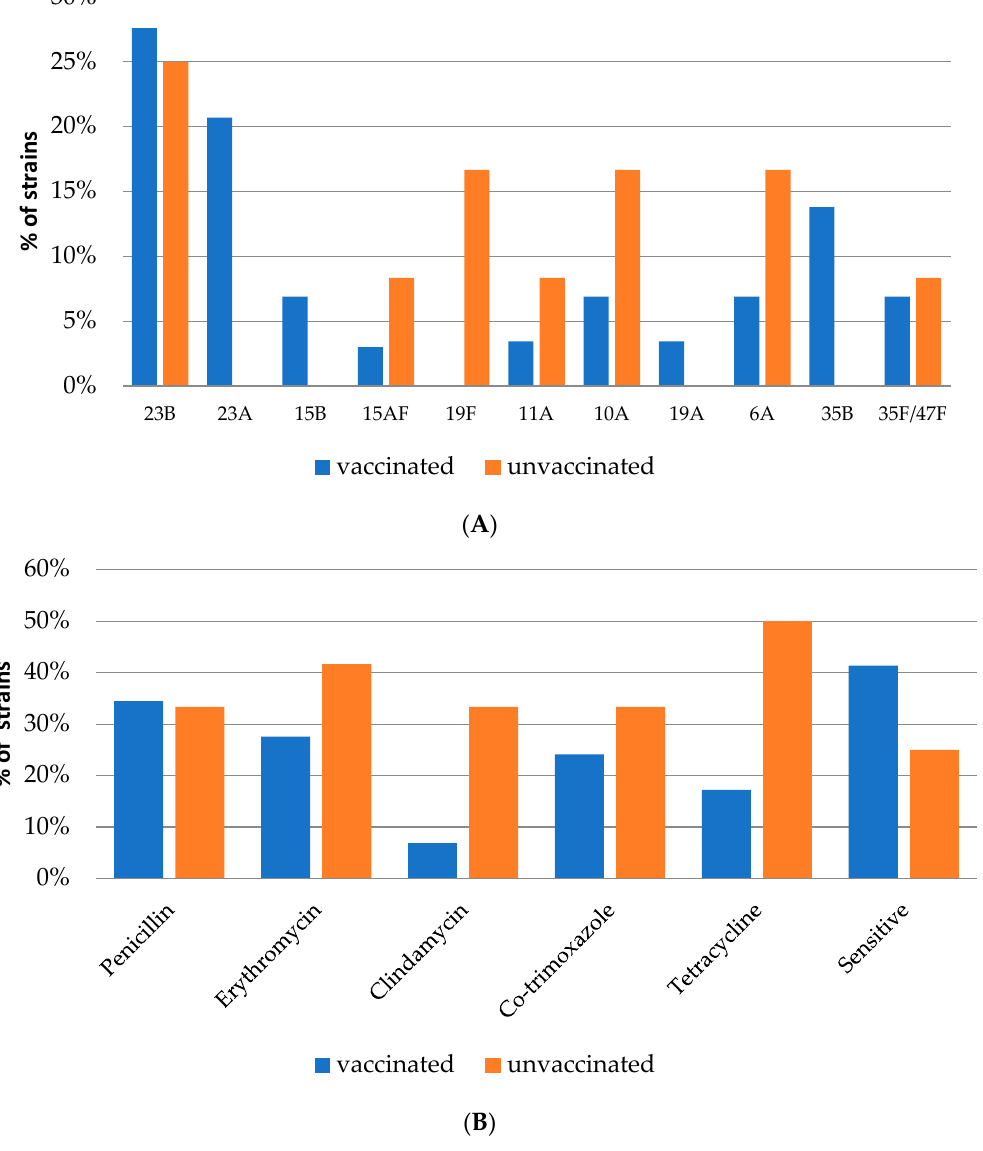
Figure 1. Serotype-specific prevalence ( A ) and antibiotic resistance ( B ) among pneumococci carriage isolates in unvaccinated and in vaccinated children, 1–6 years old in Poland.